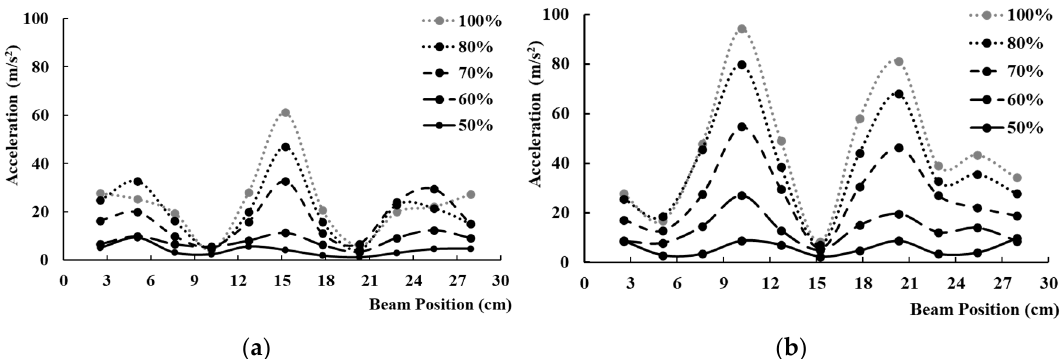
Figure 5. Acceleration along the beam, exciting a single actuator, varying the actuator’s magnitude between 50 and 100% at a frequency of: ( a ) 168 Hz; ( b ) 196 Hz.